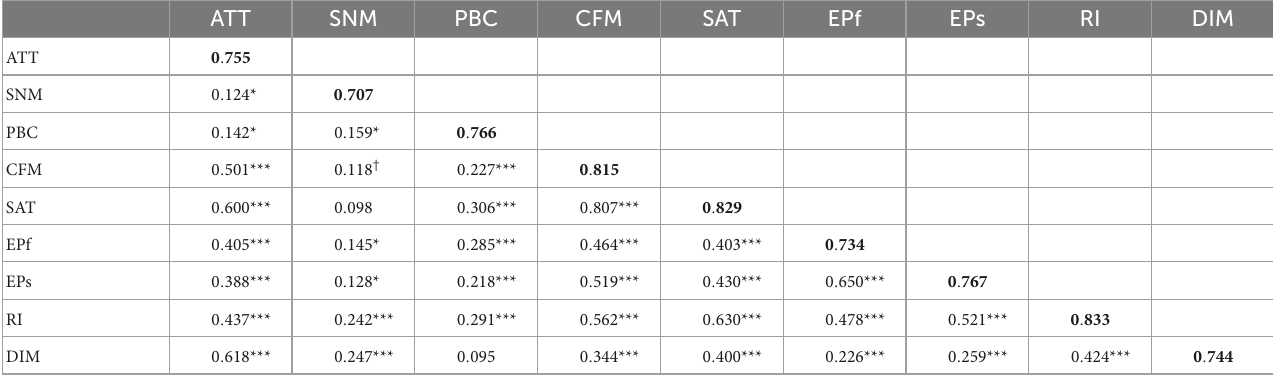
TABLE 5 Discriminant